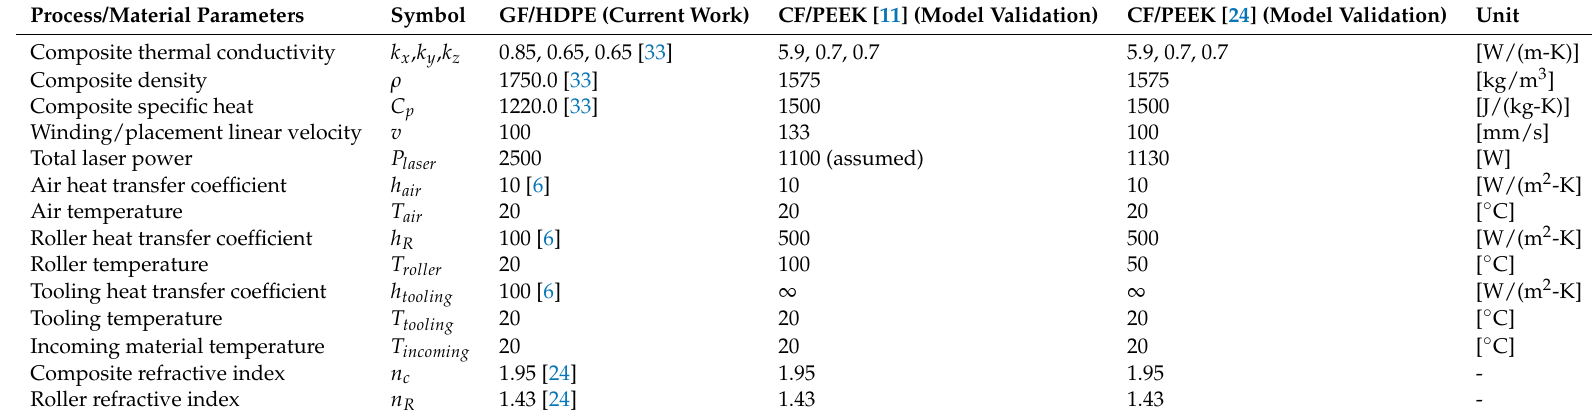
Table 2. Process and material properties used in the current modeling work and model validation based on the available data in References [11,24]. Process/Material